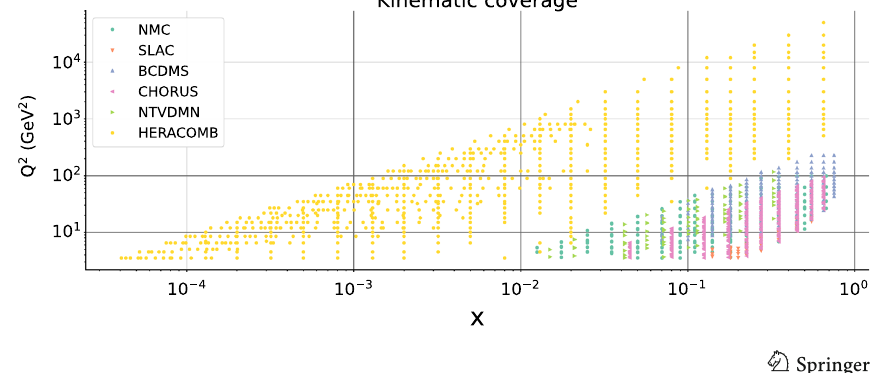
Fig. 1 The kinematic coverage in the ( x , Q 2 ) plane of the DIS dataset used for the determination of the PDF sets discussed in this